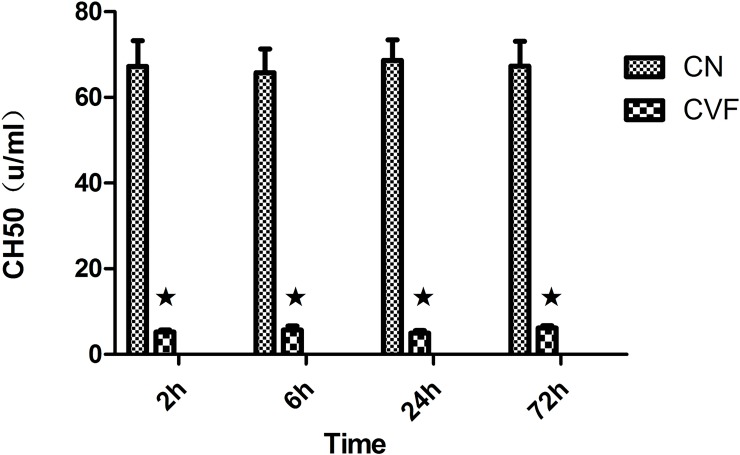
Levels of serum CH50.Each bar represents the mean±SD. ★ P<0.01 vs. control.